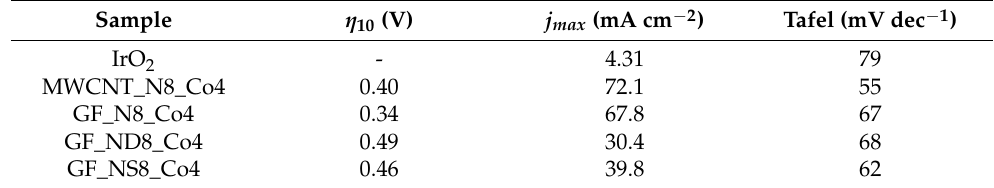
Figure 10. OER LSV curves obtained in KOH (0.1 M) saturated with N 2 for MWCNT_N8_Co4, GF_N8_Co4, GF_ND8_Co4, and GF_NS8_Co4 at 1600 rpm and 0.005 V s − 1 ( a ), the corresponding OER Tafel plots ( b ), and the chronoamperometric responses in 0.1 mol dm − 3 O 2 –saturated KOH for 36,000 s and at 1600 rpm ( c ). Table 5. Overpotential for j = 10 mA cm − 2 ( η 10 ), maximum current density values ( j max, at 1600 rpm) and Tafel slopes, and determined from the OER LSV curves in N 2 -saturated 0.1 M